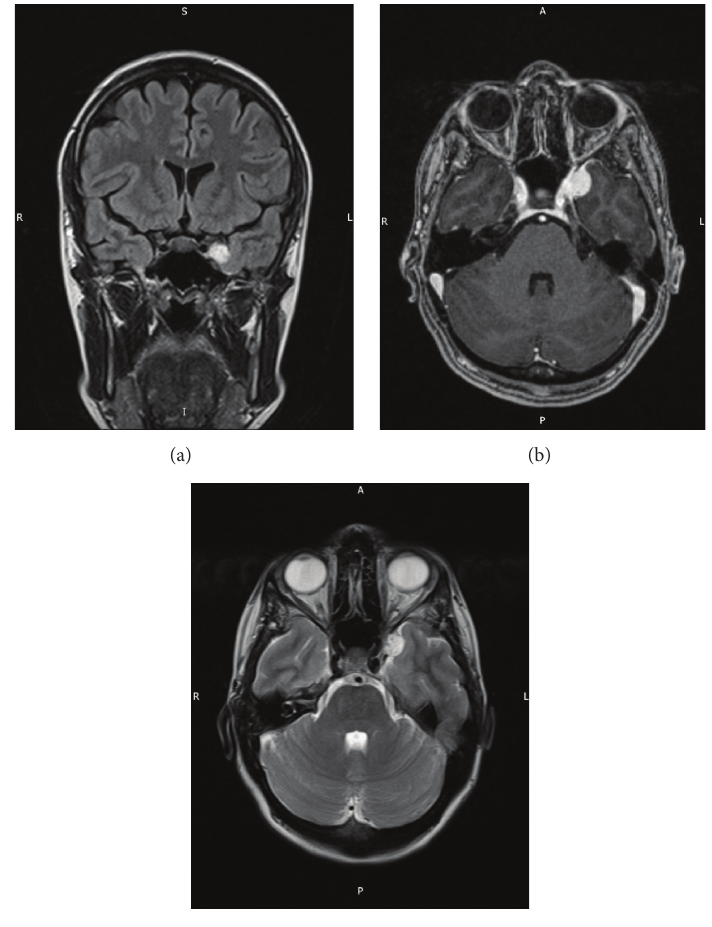
Figure 1: MRI images of a left sided lateral wall cavernous sinus meningioma coronal flair (a), T1 with contrast (b), and T2 axial (c).